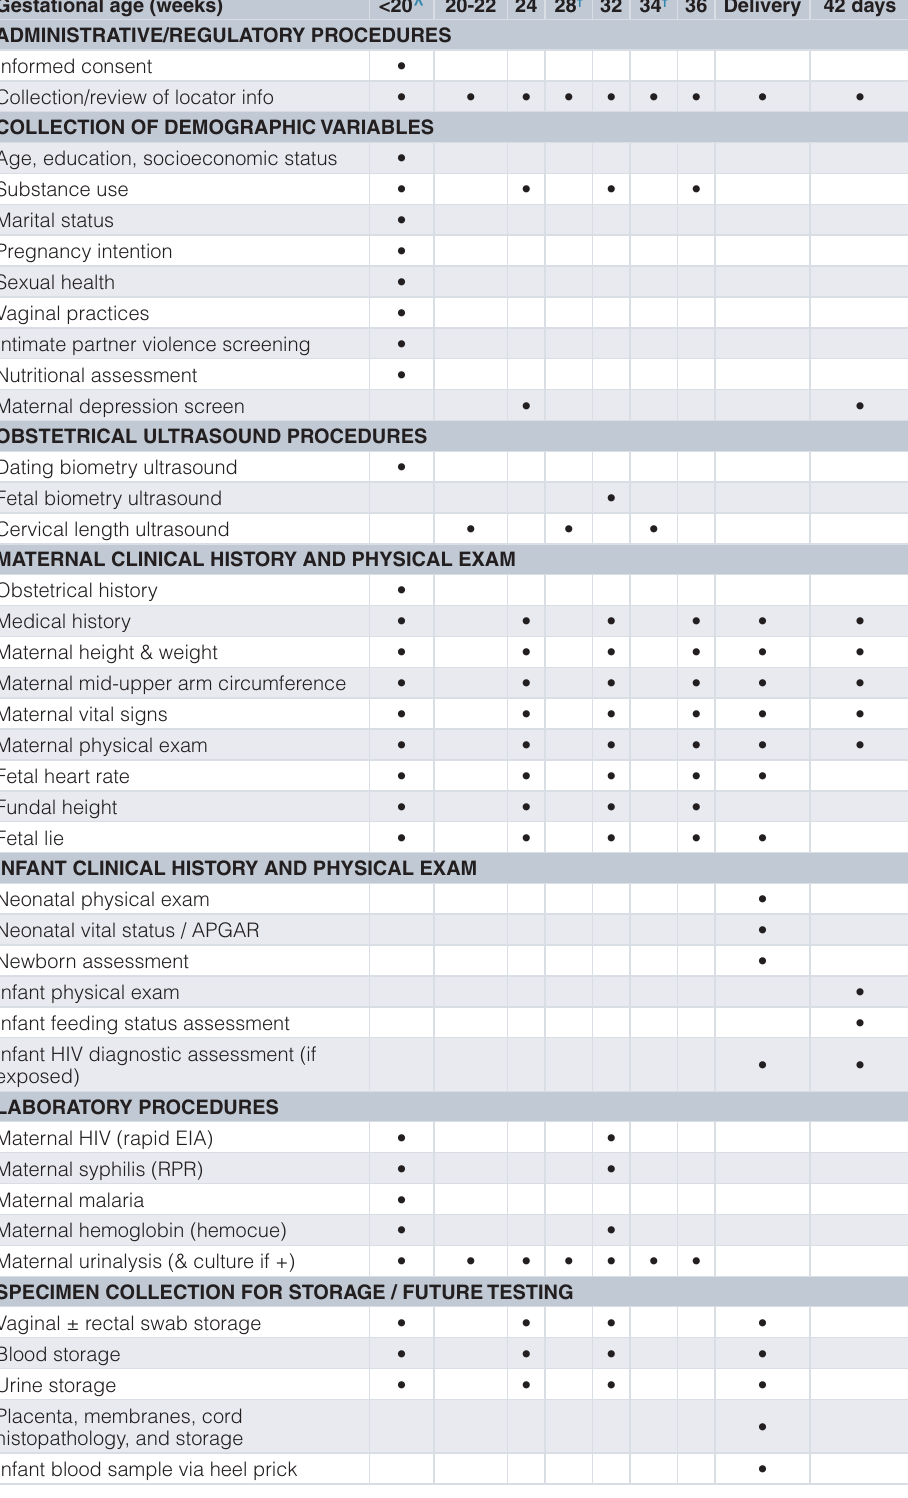
Table 1. Schedule of events, demographic and clinical data collected among all participants in ZAPPS cohort. Gestational age